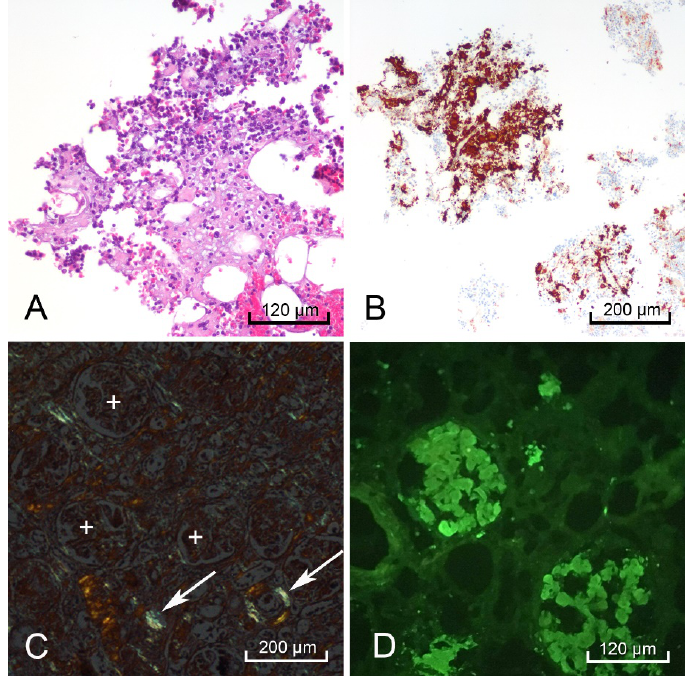
Figure 4. Postmortem bone marrow scraping with hematoxylin & eosin (H&E) staining showed hyaline extracellular matrix surrounding multiple cells ( A ). CD138-positive cells stained brown indicating the bone marrow contained numerous plasma cells ( B ). The right kidney demonstrated positive apple-green birefringence with Congo-Red stain in the blood vessel walls (white arrows), but not in the glomeruli (white +) ( C ), and a positive pattern with lambda light chain immunofluorescence in the glomeruli ( D